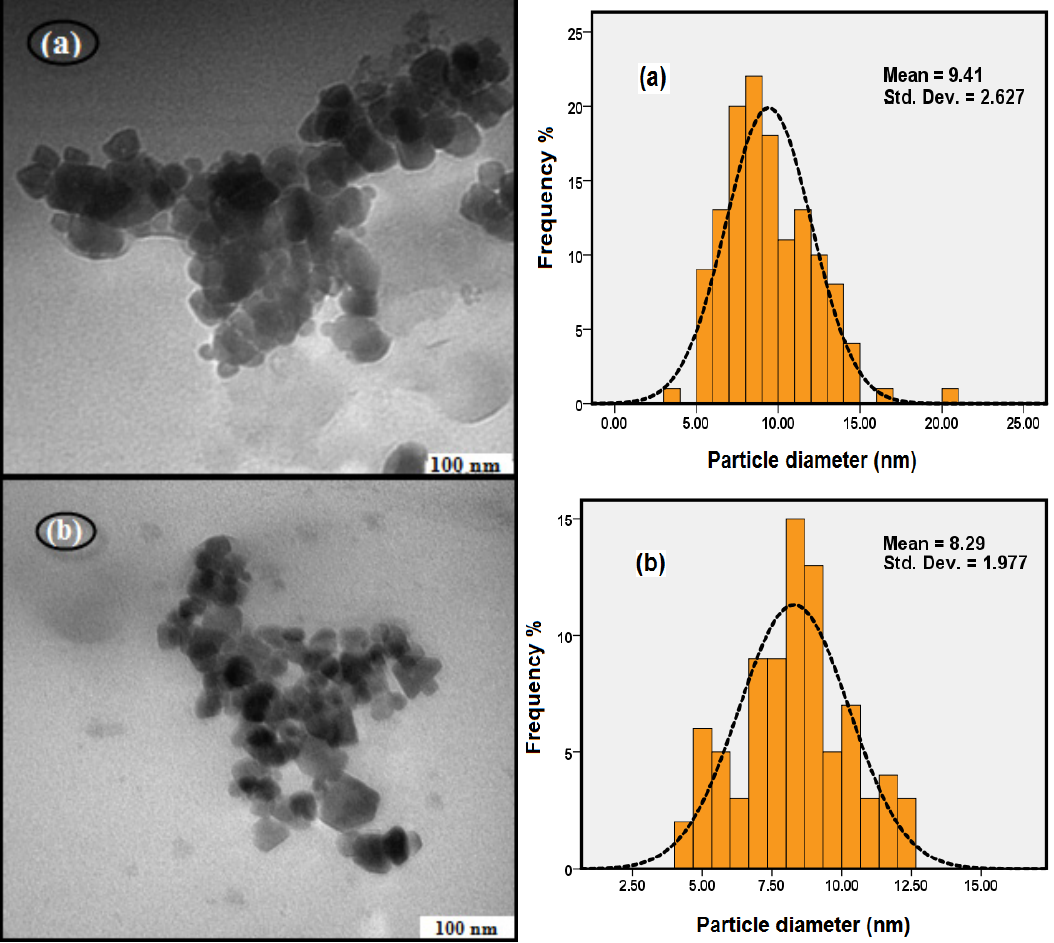
Figure 3. TEM images of Fe and ( c ) 800 rpm (pH: 11, initial Temp: 45